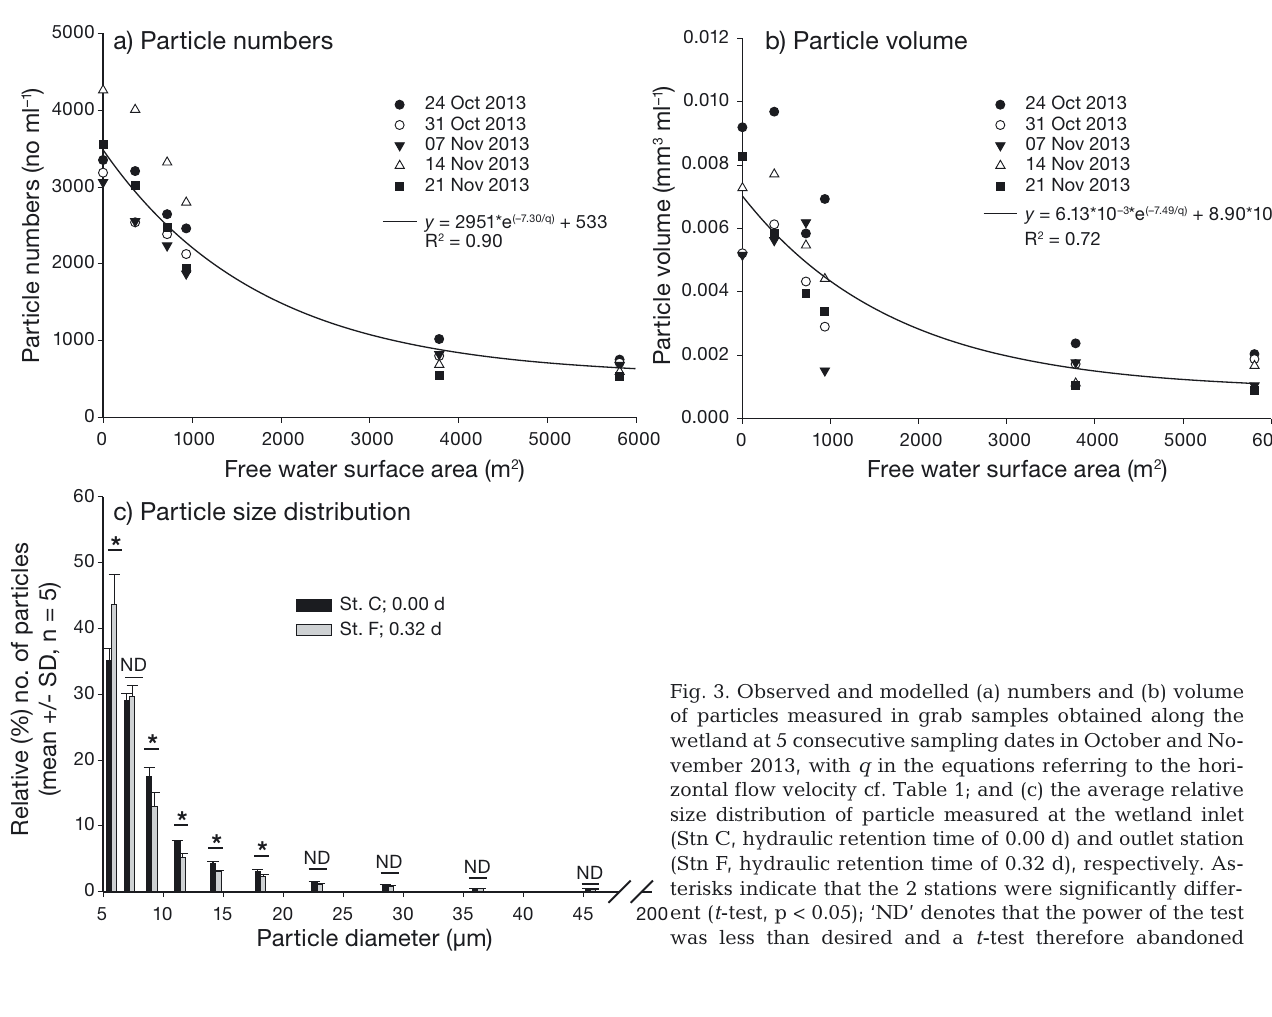
Fig. 2. (a) Temperature and (b) oxygen concentrations measured at increasing hydraulic retention time (HRT, in d) relative to the wetland inlet station (Stn C, cf. Fig. 1) during the year of sampling. Data are shown as running averages of 3 concurrent sam- pling events. Some temperature and oxygen measurements were missing from the time series and an average temperature was reconstructed based on archival temperature records from DMI (2017). This was done by translating the officially registered av- erage monthly temperatures for the region (Nordjylland, Denmark) to fit the measured, average temperatures in the wetland by multiplying the former by a factor derived by minimizing the sum of squared residuals between the 2 measurements using the Solver GRG non-linear function in Microsoft Excel®